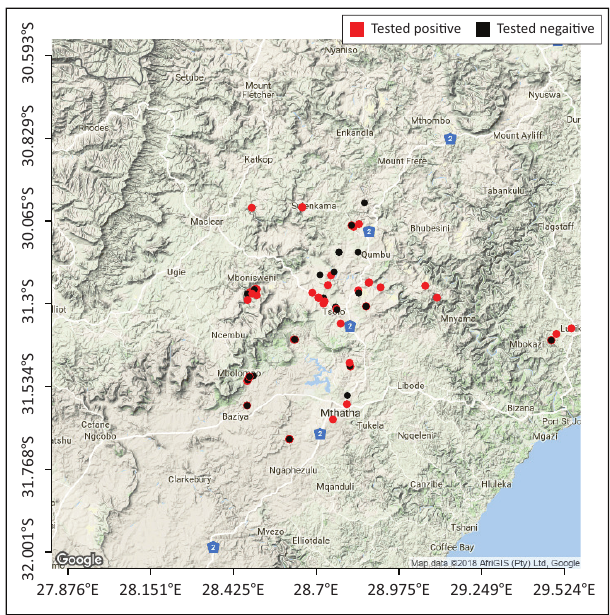
FIGURE 1: Geographic distribution of sampled households with sheep (red dots indicate positive test results and black dots indicate negative test